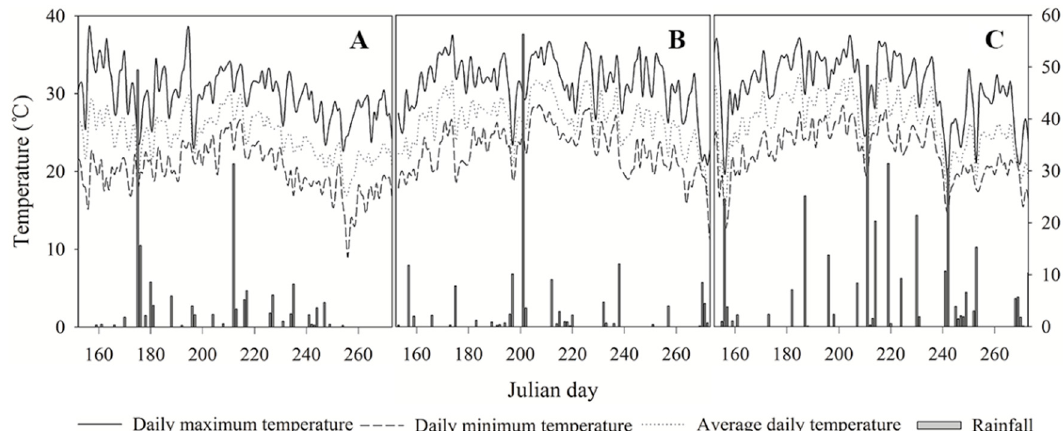
Figure 1. Daily temperature and rainfall of field experiments during three growing seasons at Heze city in 2015 ( A ) and Zhengzhou city in 2016 ( B ) and 2017 ( C ), respectively.